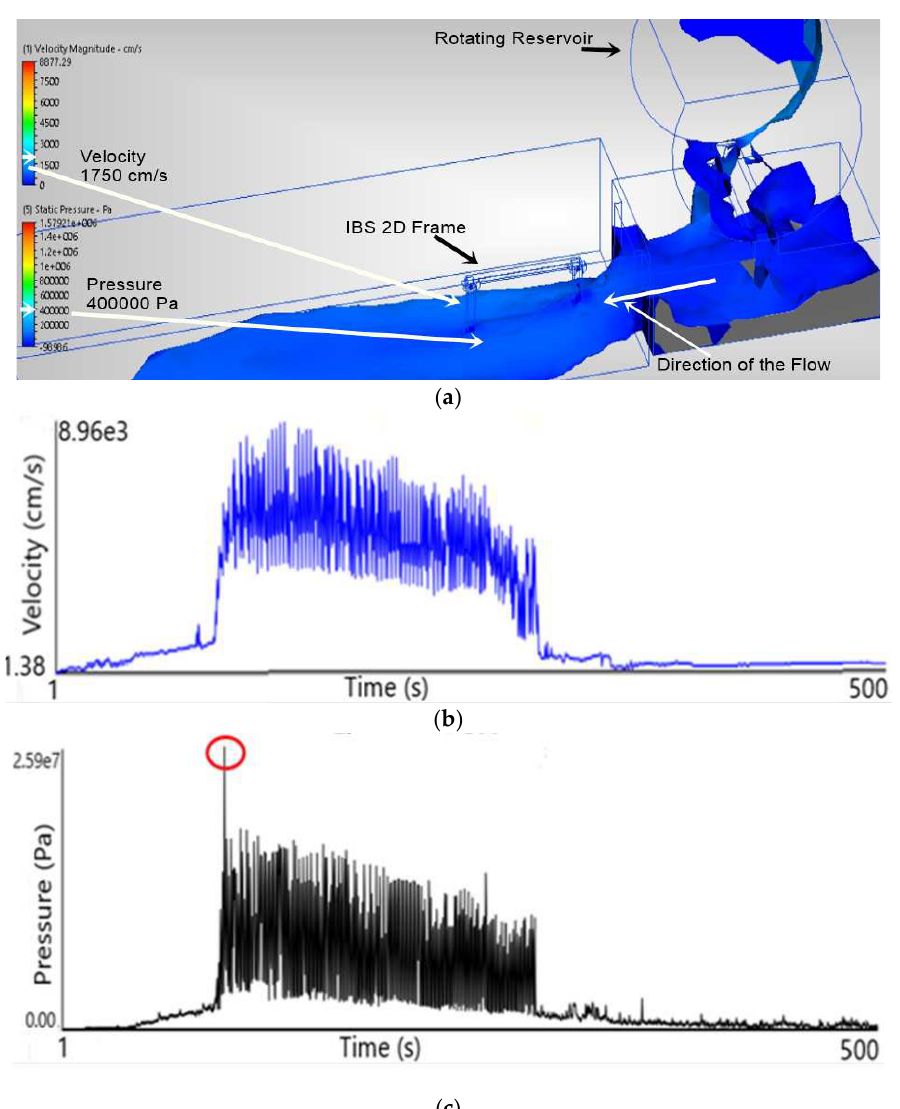
Figure 12. Illustrations of the CFD results for 2D frame: ( a ) simulated fluid flow; ( b ) maximum velocity; ( c ) maximum pressure. velocity; ( c ) maximum